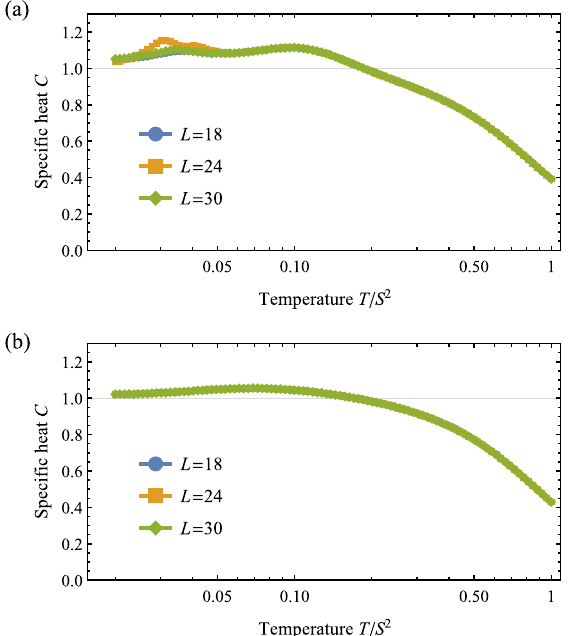
Fig. 6 Speci fi c heat at fi nite temperatures. a At h / S = 0.85, system- size dependent cusps around T / S 2 = 0.03 indicate strong fi nite-size effects and vortex crystallization. b In the vortex liquid regime at h / S = 0.95, where vortices become dilute, the curves for different system sizes coincide and fi nite-size effects are not observed. Both datasets are obtained at φ = π /4 for different system sizes L = 18, 24, 30. Statistical error bars are smaller than the plot markers.